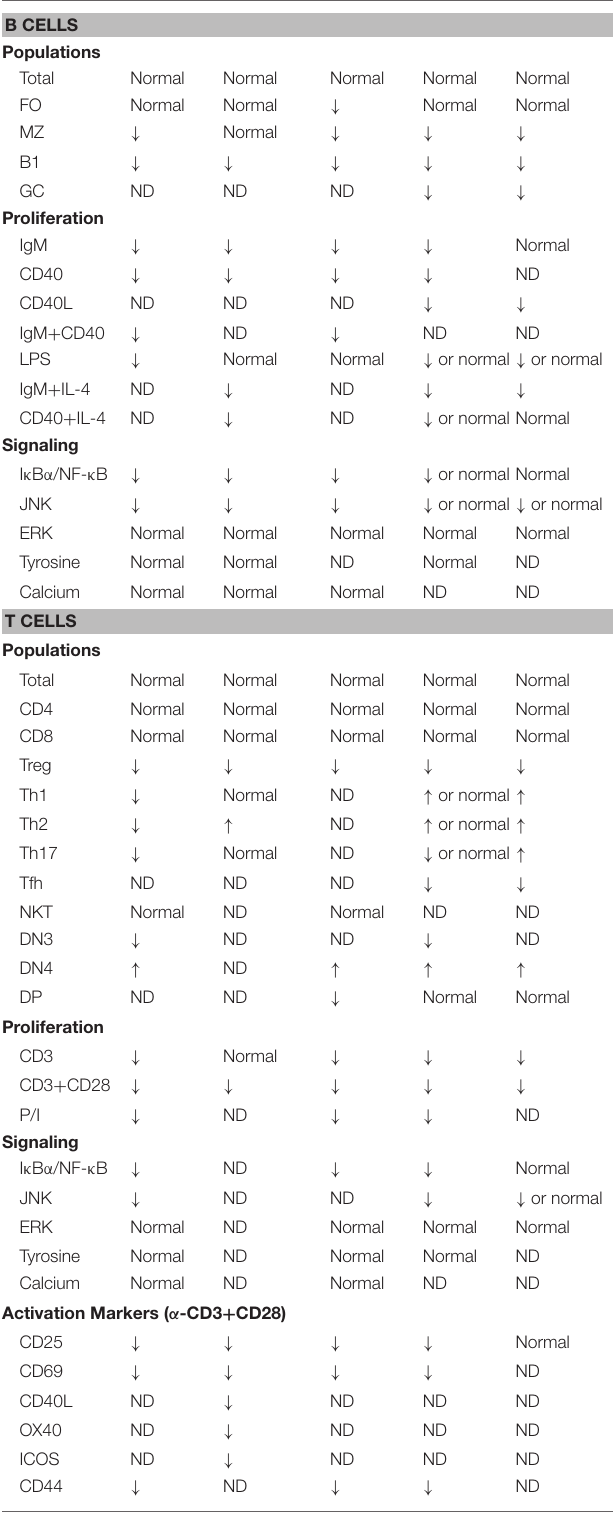
( Table 3 ). Specific testing for NF- κ B phosphorylation, I κ B